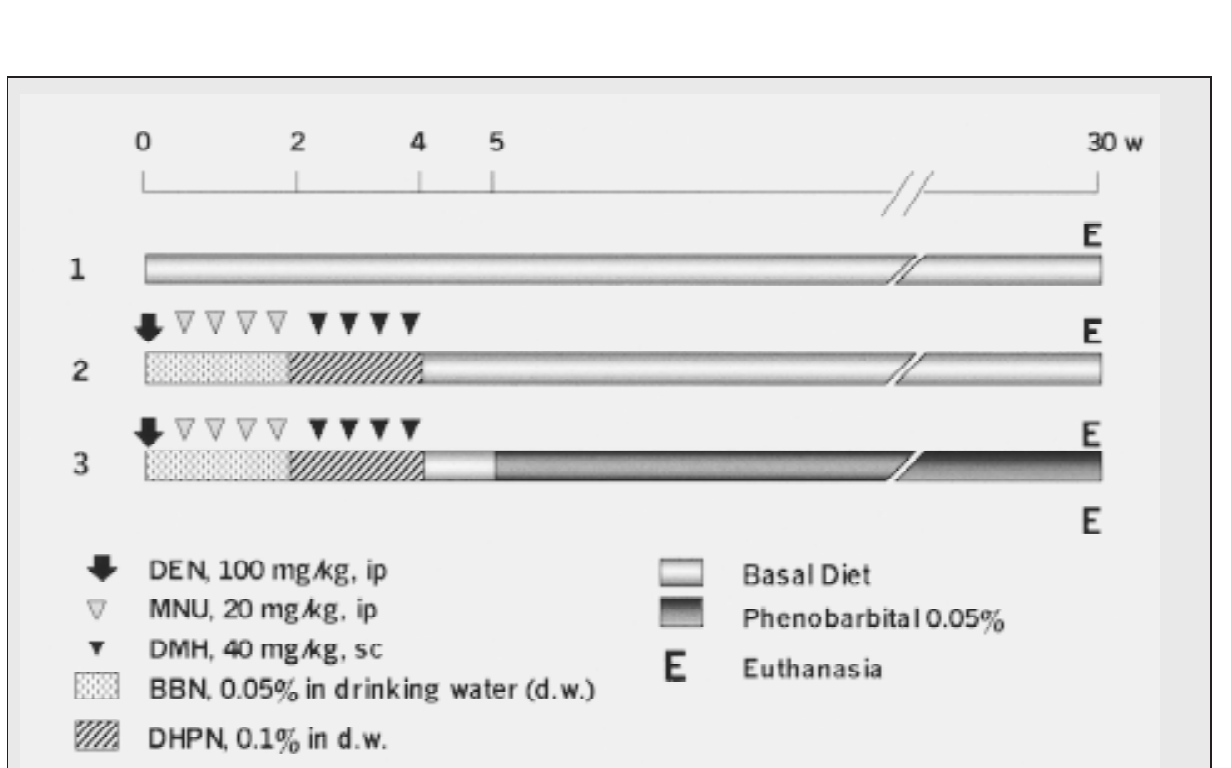
Figure 1 – Control groups of the medium-term bioassay for multiple organs, known as DMBDD